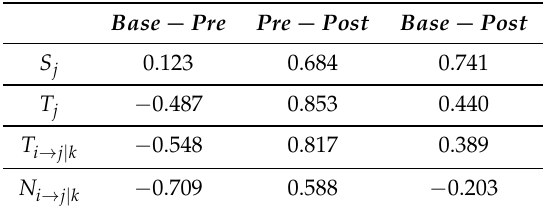
Table 5. Cohen’s d effect size—Focal seizures—Source